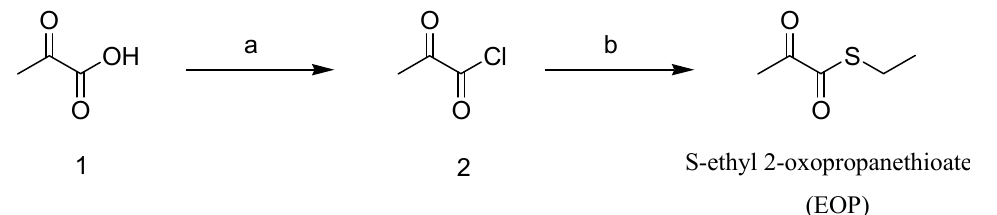
Figure 1. Synthesis of the novel S-ethyl 2-oxopropanethioate, ethyl pyruvate derivative,